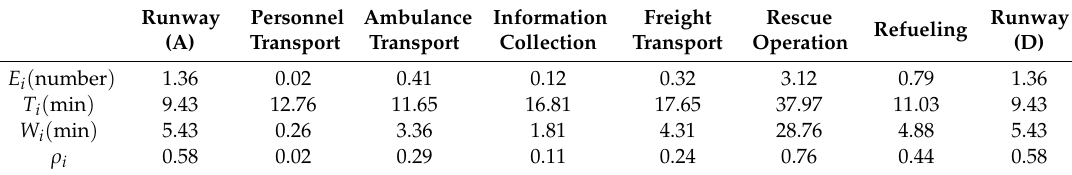
Table 6. Performance measurement for first-come first-served (FCFS) case: Hanamaki Airport.